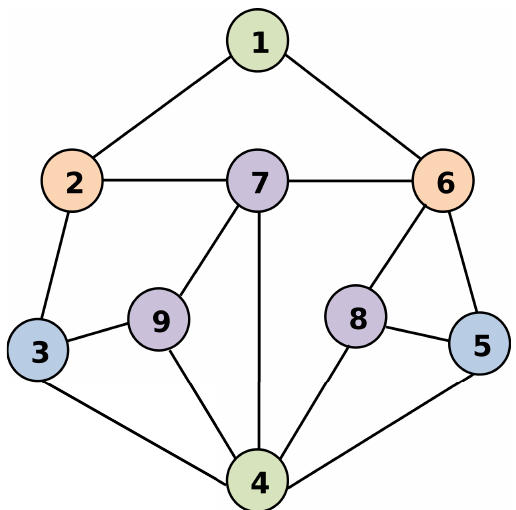
Figure 2. Topology structure of impulsive network (21).